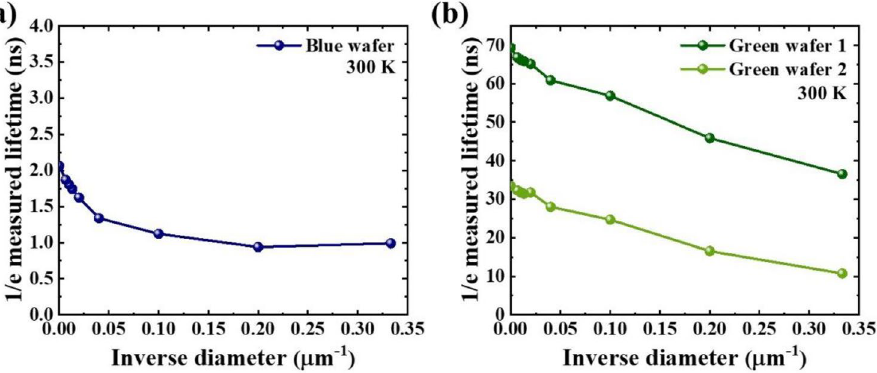
Figure 3. Measured carrier lifetimes as a function of inverse of the chip diameter, which were extracted from the time decay when PL intensity reduces to 1/e of its maximum, for ( a ) blue LED wafer and ( b ) two green LED